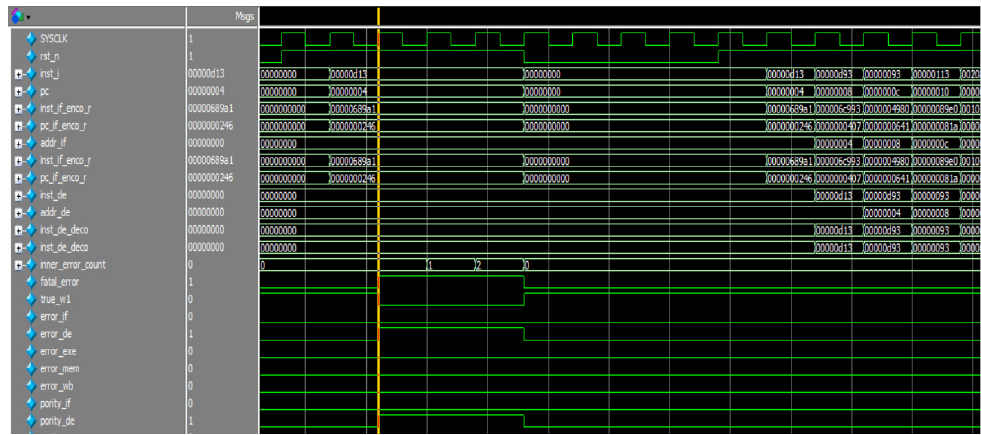
Figure 28. Fatal error handling diagram.